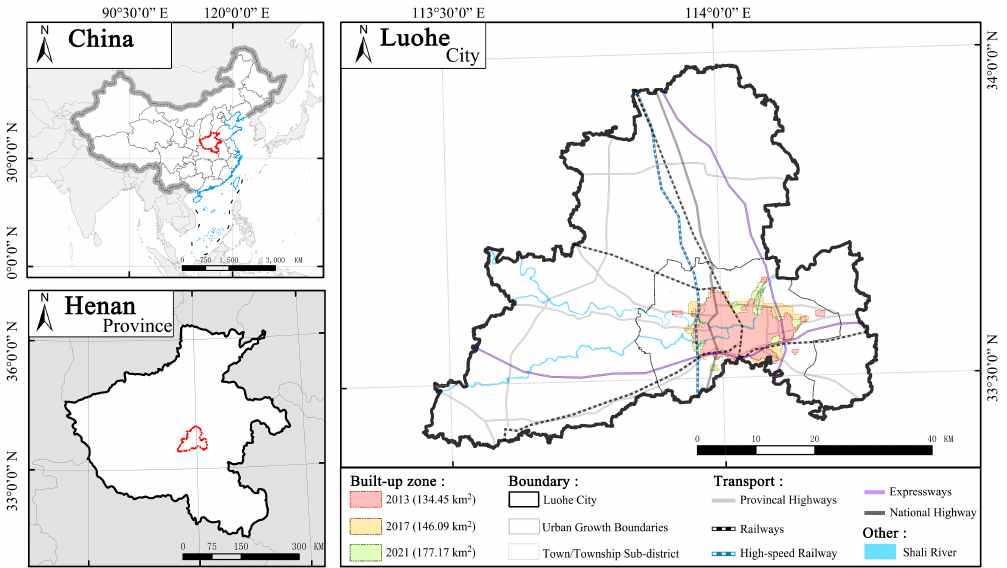
Figure 2. Location map (map of China from China Standard Map Service. GS (2020)4619).